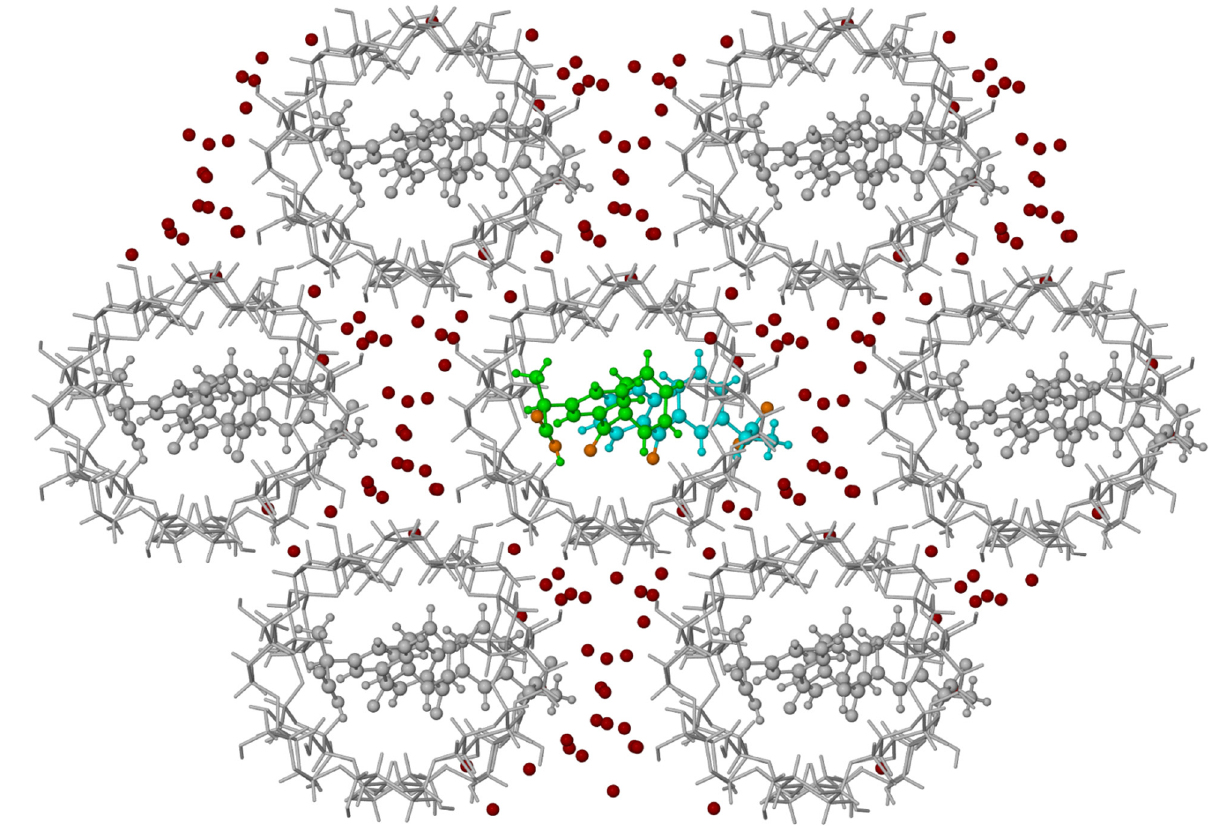
Figure 8. View of crystal packing along the b-direction showing a close neighbourhood of 2:2 KP/ β -CD ( β -cyclodextrin) inclusion complex. Only O-atoms of water molecules are shown.